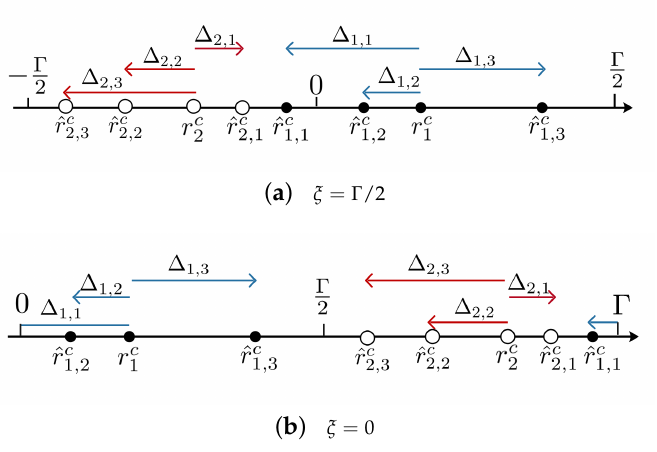
Figure 2. Sketch of the Definition of ˆ r c